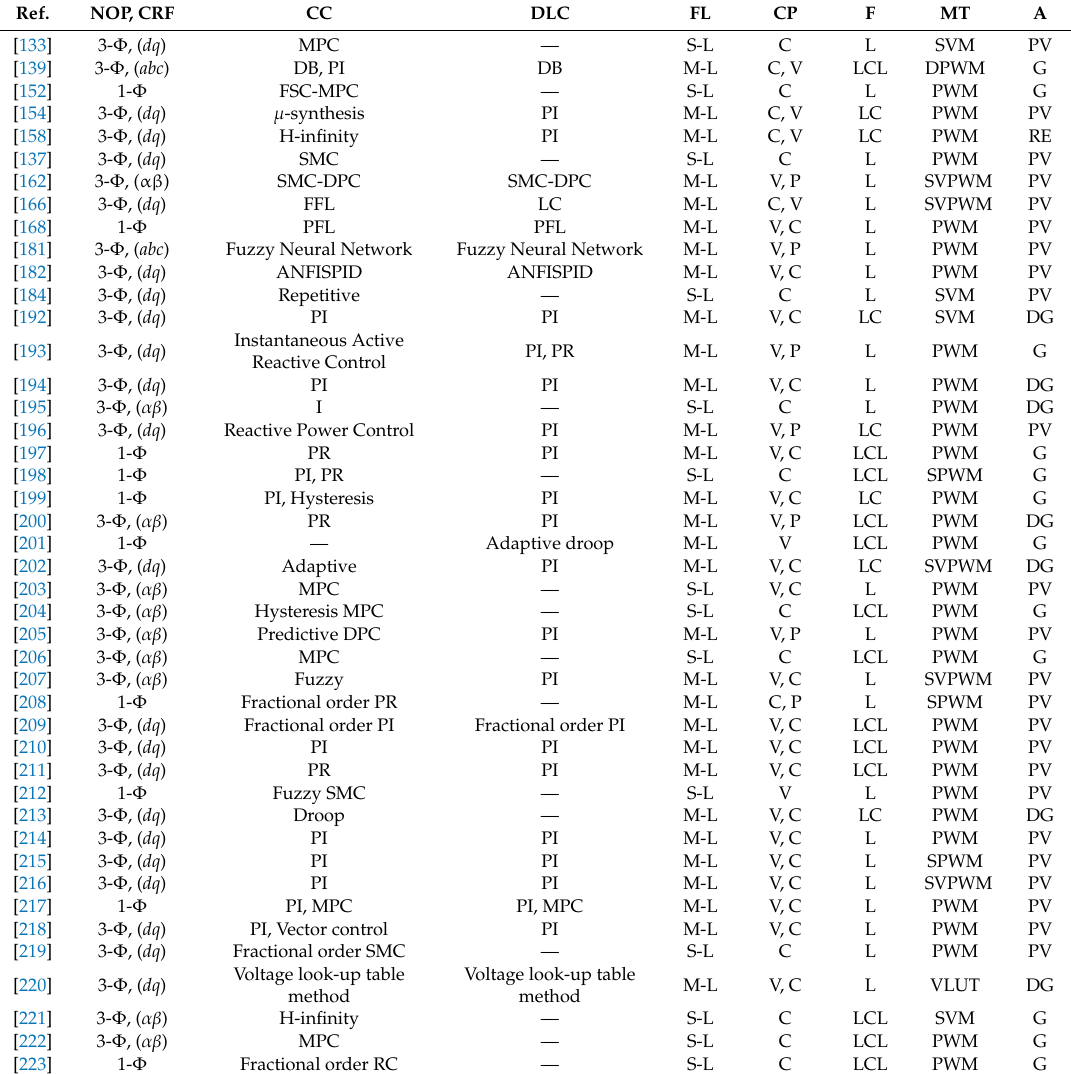
Table 6. Main characteristics of di ff erent controllers proposed in scientific